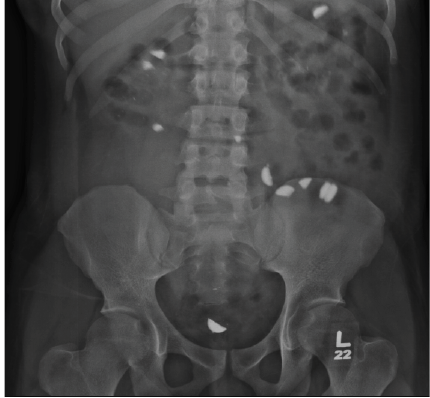
Figure 2: Repeat abdominal radiograph from 6/28/18 shows radiopaque objects moving towards rectum.